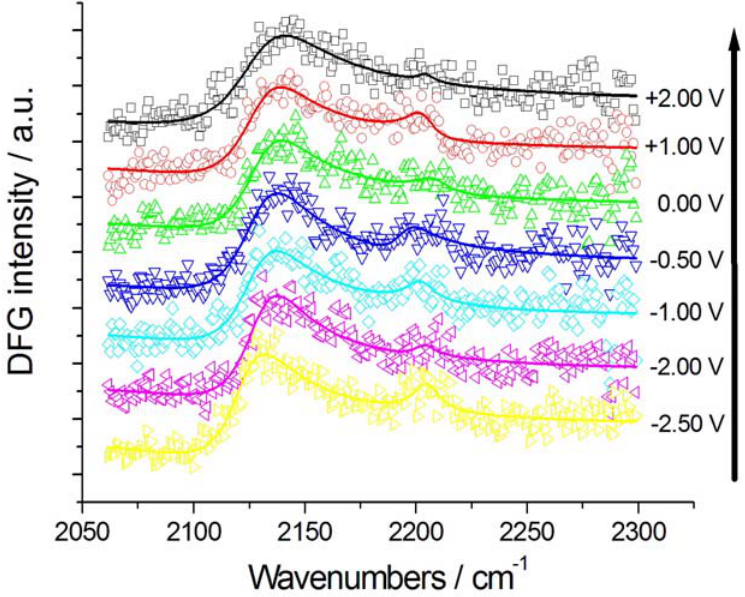
Figure 4. Potential-dependent DFG spectra of Au in contact with [BMP][TFSA] containing ] and the corresponding fits: anodic-going scan (from 1 mM CTDB and 25 mM K[Au(CN) 2 − 2.50 V to +2.00 V, starting with pristine Au electrode). The potential scan sequence (anodic-going scan) is indicated by the